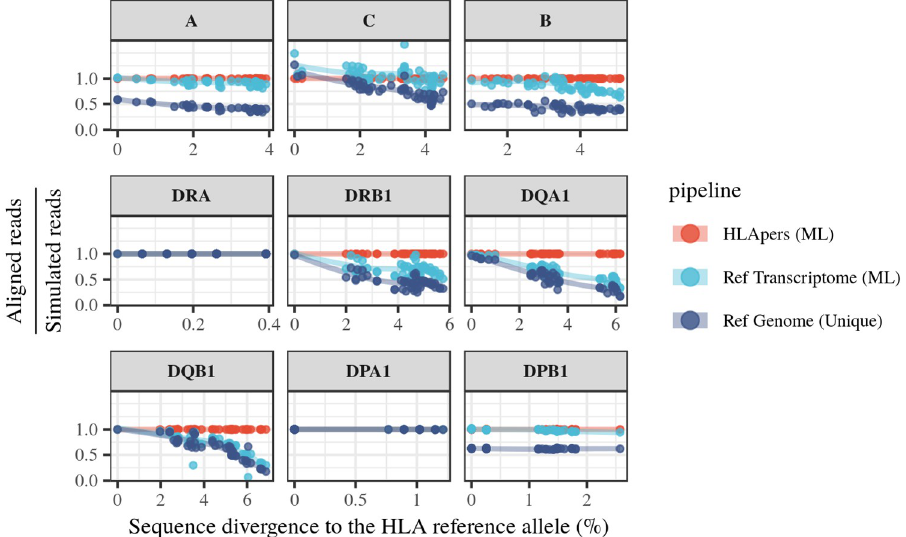
Fig 2. Alignment success with three different methodologies. The proportion of simulated reads which successfully aligned is defined for each locus by the ratio of the estimated read counts to the number of simulated reads (y-axis). These values are displayed as a function of the divergence of the HLA allele to the reference genome (x-axis). Simulated reads were processed through 3 different pipelines: (1) alignment to the personalized HLA sequences ( HLApers (ML) ), (2) alignment to the reference transcriptome ( Ref Transcriptome (ML) ), (3) alignment to the reference genome considering only uniquely mapped reads ( Ref Genome (Unique)